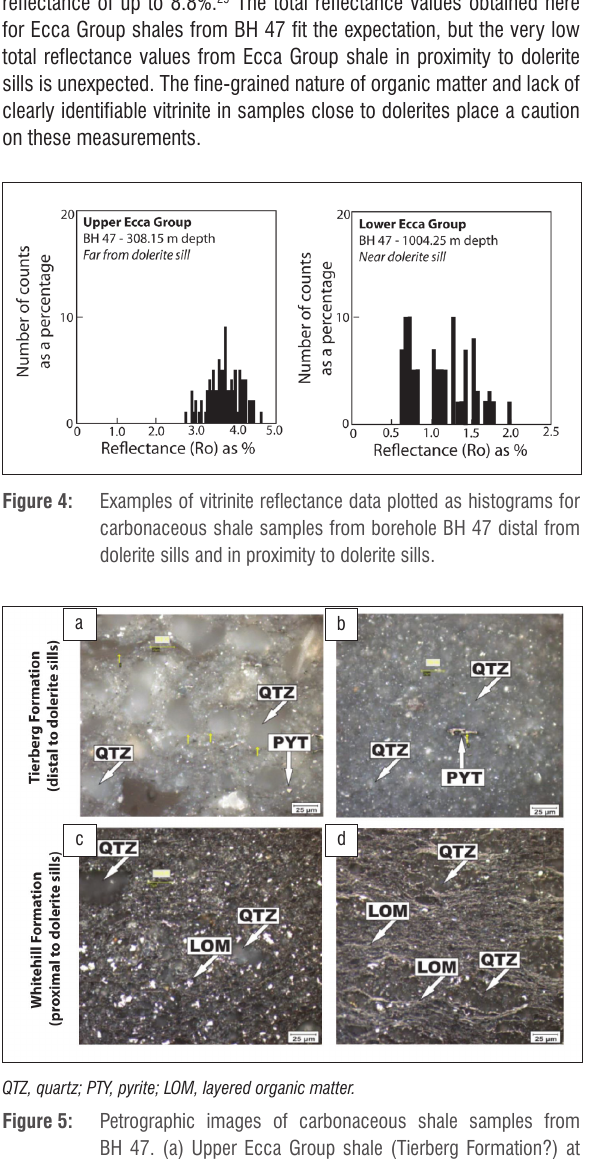
Figure 5: Petrographic images of carbonaceous shale samples from BH 47. (a) Upper Ecca Group shale (Tierberg Formation?) at 308.15 m depth distal from dolerite sills. (b) Upper Ecca Group shale (Tierberg Formation?) at 766.64 m depth distal from dolerite sills. (c) Whitehill Formation equivalent at 1004.63 m depth in proximity to a dolerite sill. (d) Whitehill Formation equivalent at 1011.25 m depth in proximity to a dolerite sill.